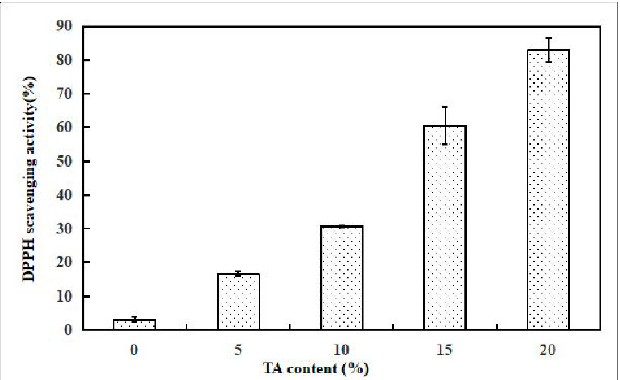
Figure 8. Antioxidant activity of the neat GG and of GG fibrous mats loaded with TA.